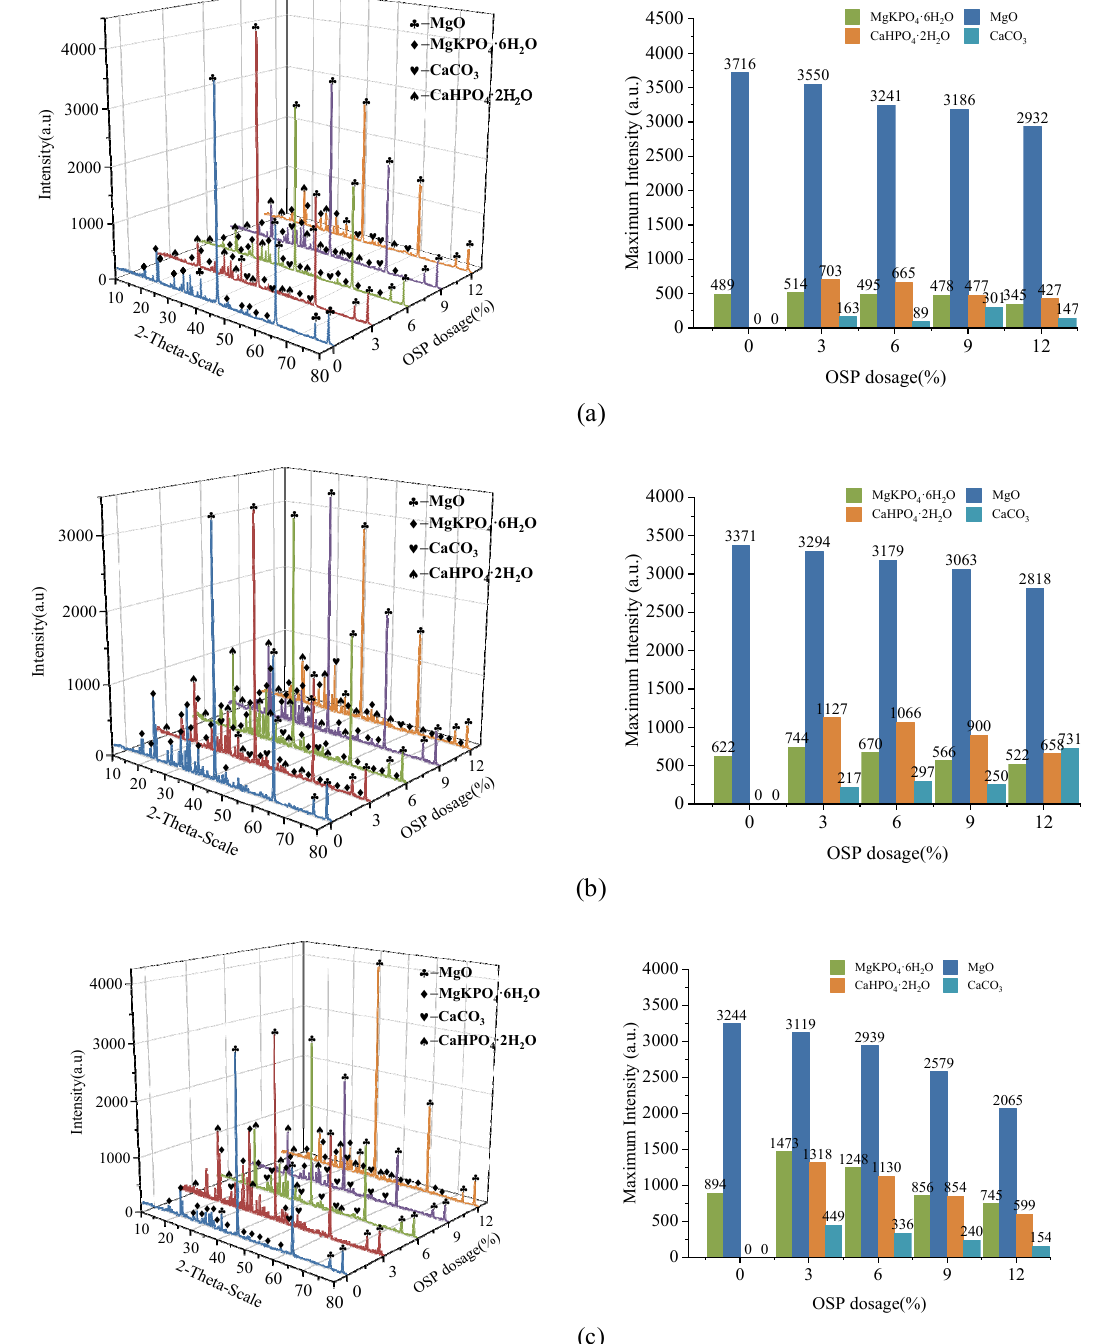
Figure 12. X-ray diffraction (XRD) analysis of specimens. ( a ) T7; ( b ) T14; ( c )